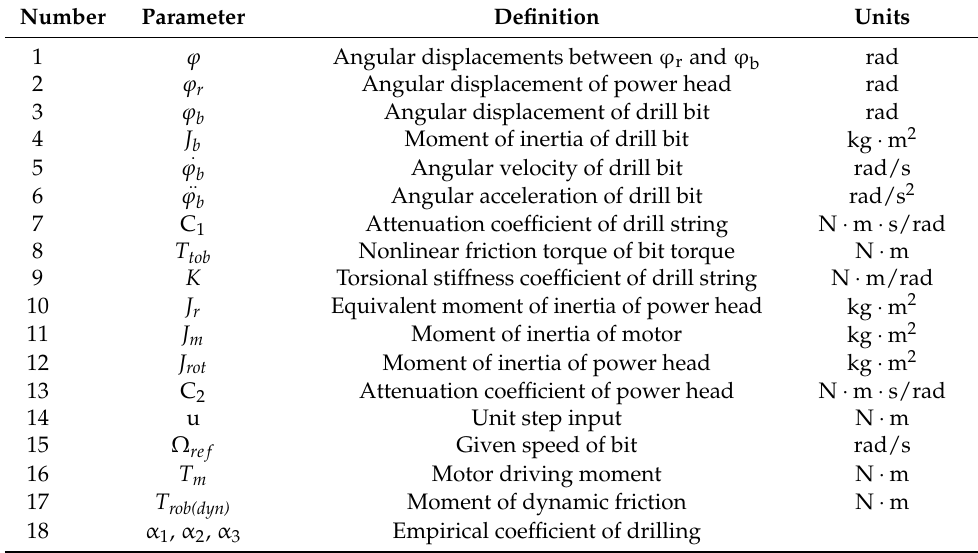
Table 1. Parameters and variables characterizing the rotation